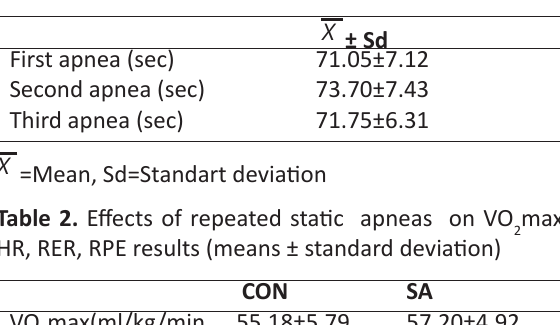
Table 1. means ± standard deviation of apnea duration